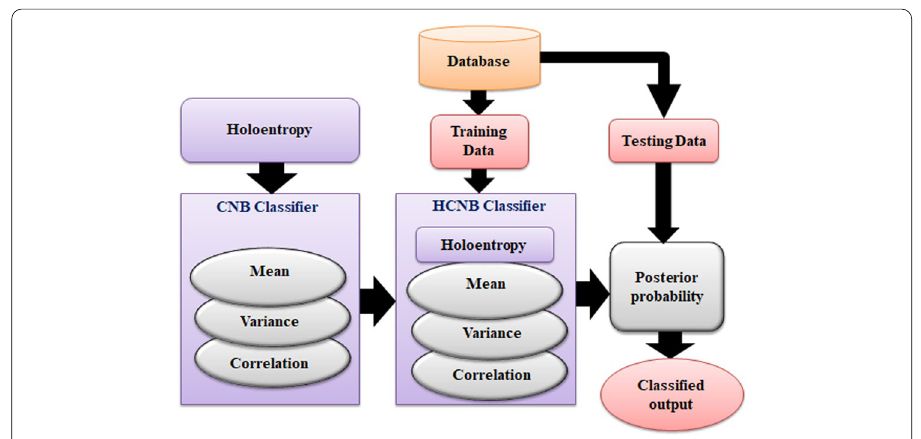
Fig. 2 Block diagram of HCNB